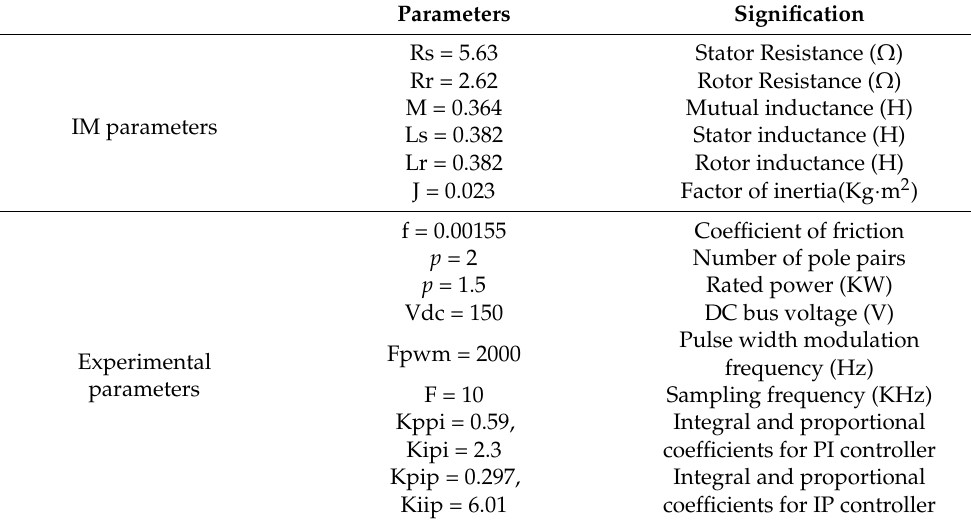
Table 2. Experimental and machine parameters.